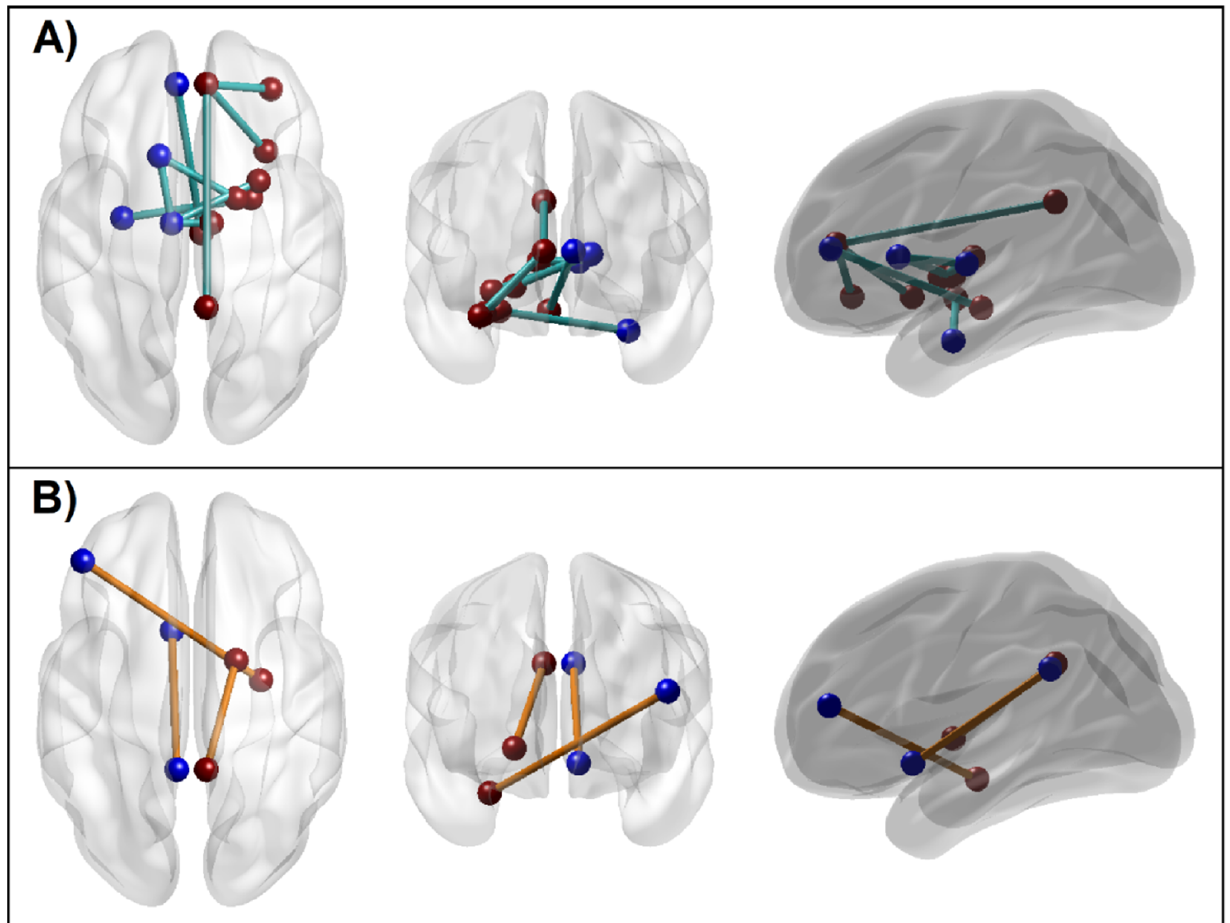
Figure 7. Significant reward network connections that contribute to the random forest classification of alcohol use disorder (AUD) from control (CTL), as listed in Table 3. ( A ): Hypoconnectivity manifested by the AUD group (cyan lines) across cortical and subcortical ROI regions of the RN, predominantly involving right hemisphere structures; ( B ): Hyperconnectivity in three connections manifested by the AUD group (orange lines). Images within each panel: Left: axial (top) view; Middle: coronal (front) view; Right: sagittal (left) view.